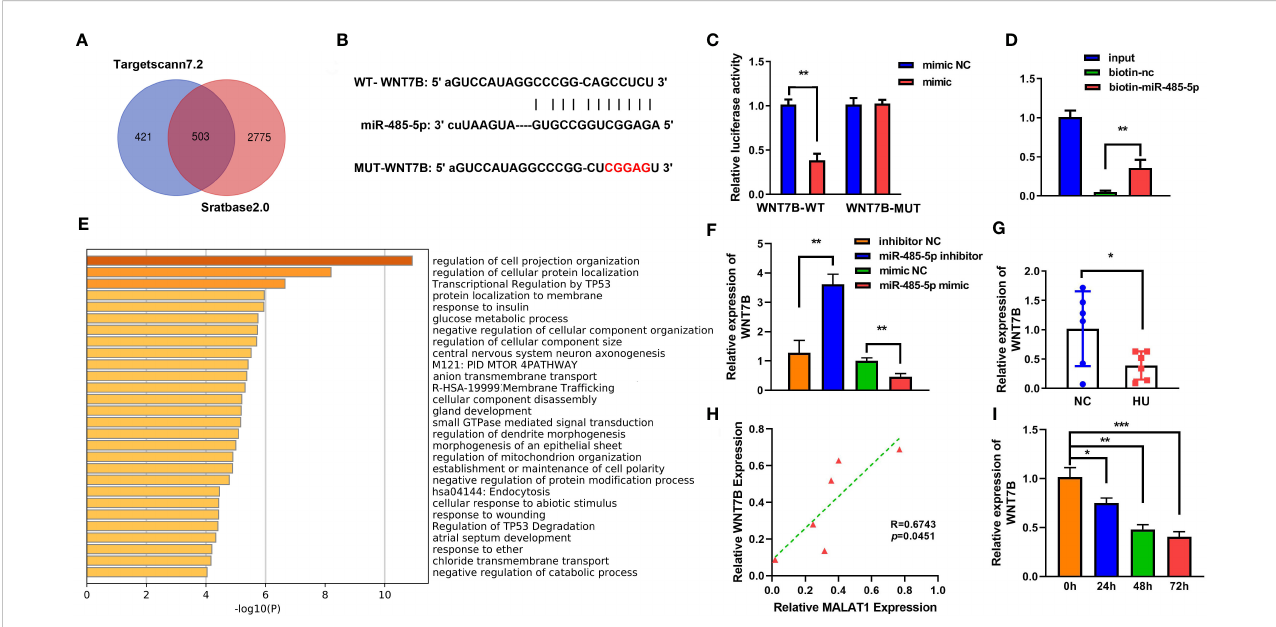
FIGURE 6 WNT7B is a direct target of miR-485-5p. (A) The potential target of miR-485-5p was predicted by Starbase2.0 and TargetScan7.2. (B) Potential binding sites for miR-485-5p to WNT7B were predicted by TargetScan. (C) The targeted relationship between miR-485-5p and WNT7B was con fi rmed by dual- luciferase reporter assay. (D) The targeted relationship between miR-485-5p and WNT7B was con fi rmed by RNA pull-down. (E) GO analysis of biological processes. (F) The expression of WNT7B was assessed by RT-qPCR after miR-485-5p overexpression and knockdown. (G) The expression of WNT7B in vivo . (H) The correlation between the expression of WNT7B and MALAT1 analyzed using Pearson analysis. (I) The expression of WNT7B detected using RT-qPCR. * p < 0.05. ** p < 0.01.